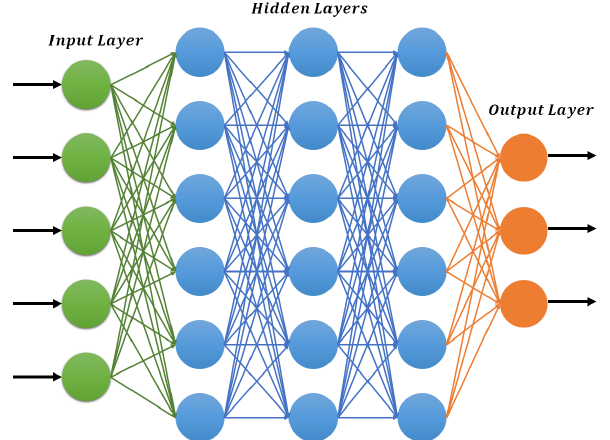
Figure 4. A general architecture of the deep feedforward neural network